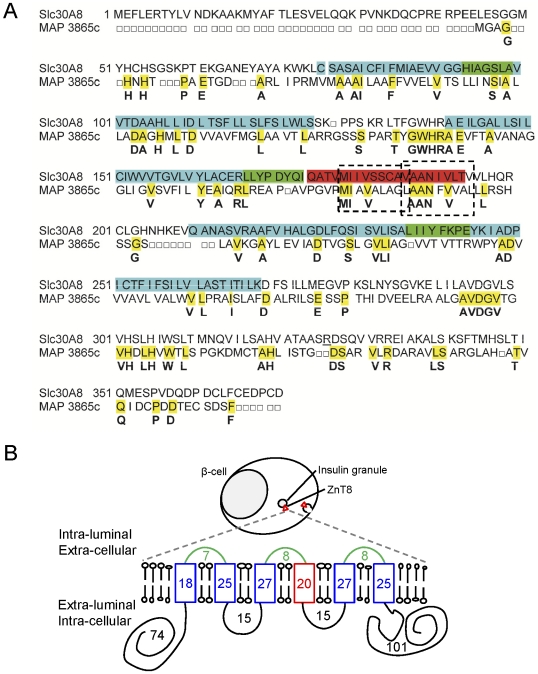
Homology between MAP3865c and ZnT8 proteins.(A) Aminoacid sequence alignment of ZnT8 (Slc30A8) and MAP3865c proteins. Conserved aminoacid residues are highlighted in yellow within the MAP3865c sequence and listed in bold below the two sequence alignment rows. The other color codes refer to the ZnT8 protein structure shown in (B): sequences highlighted in green belong to the 3 intra-luminal loops; the sequence in red belongs to the fourth transmembrane domain, while those in blue belong to the other transmembrane regions; sequences not highlighted fall within the 4 extra-luminal fragments. Dotted rectangles show the MAP3865c125–133/ZnT8178–186 and MAP3865c133–141/ZnT8186–194 peptides studied in subsequent experiments. The topology of the ZnT8 protein is also shown in panel (B), where the 3 intra-luminal loops (in green) become extracellularly exposed once the insulin granule is released. Conversely, the 4 extra-luminal domains (in black) are exposed to the cytosol and remain intracellular upon insulin exocytosis.